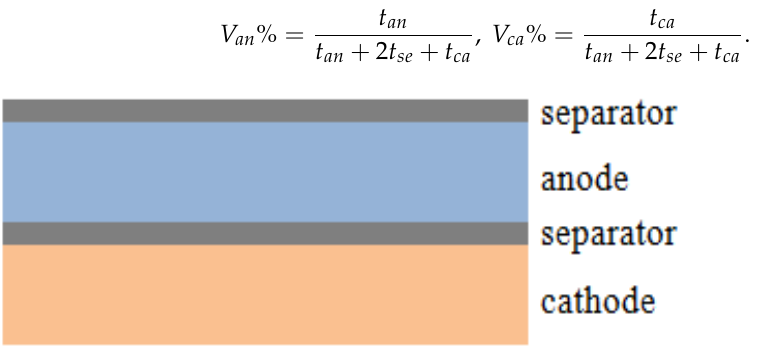
Figure 3. The schematic diagram of representative volume element of jellyroll.